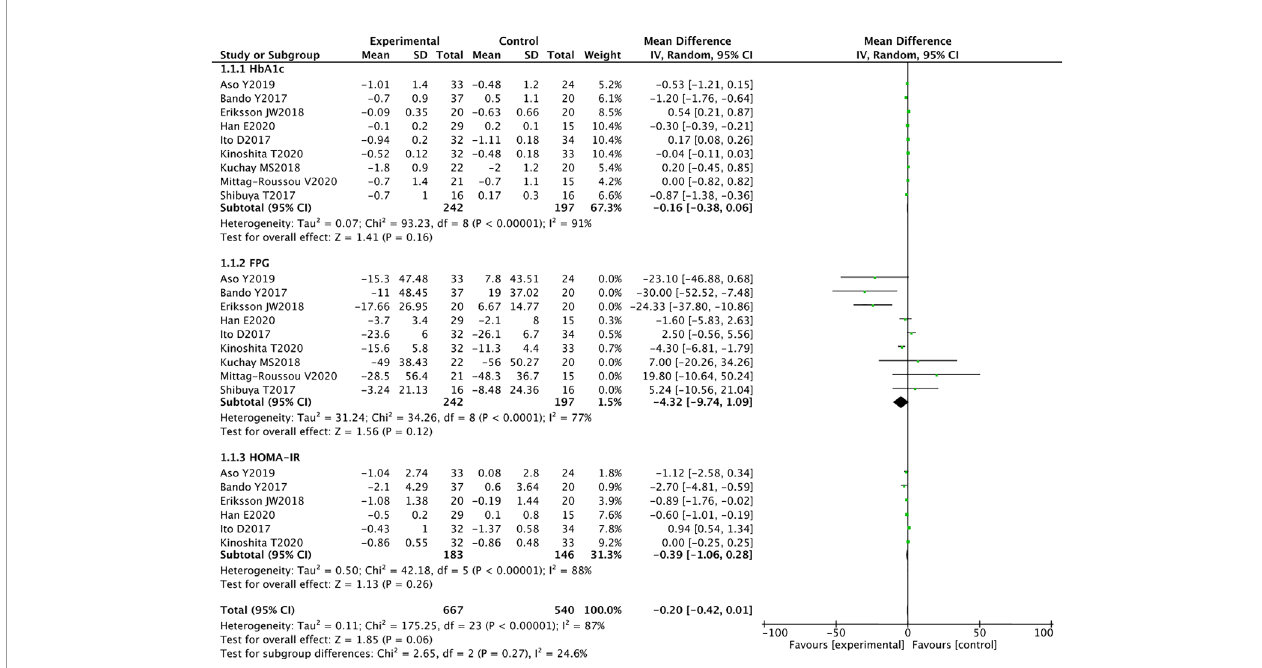
FIGURE 3 | Meta-analysis of the effect of SGLT2 inhibitors on glycemic indices compared with the control group.